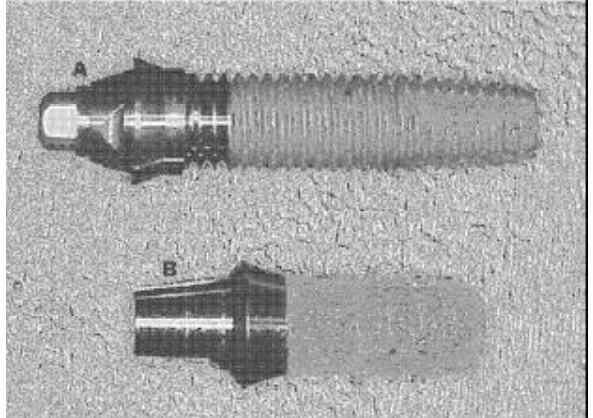
FIGURA 2- Porção rugosa e lisa nos implantes de dois estágios. Observar a presença do RBM a partir da terceira rosca (seta)